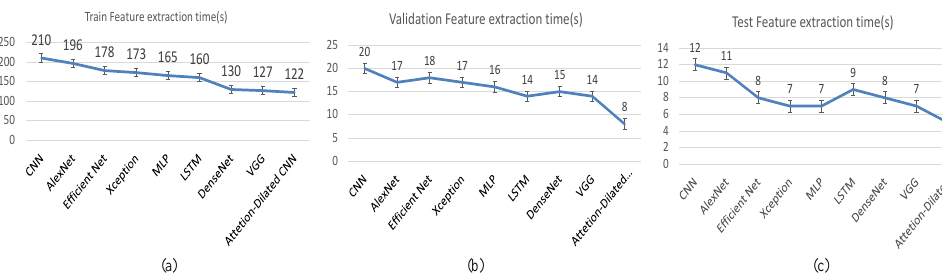
Figure 19. Comparative feature extraction time during ( a ) Training, ( b ) Validation, ( c )